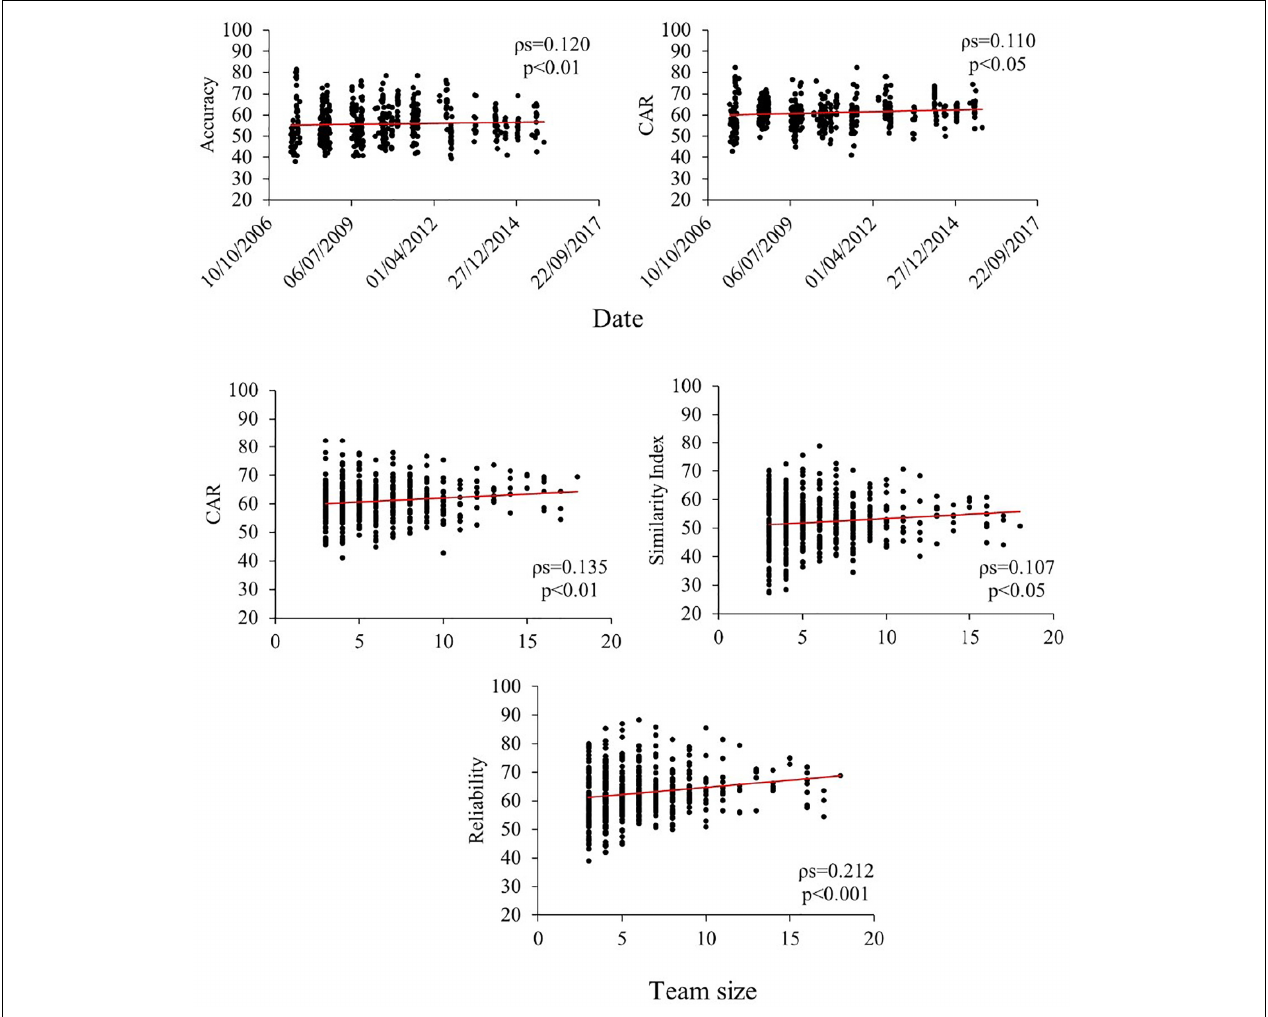
FIGURE 3 | Significant correlations between reliability parameters (Accuracy, CAR, Reliability, and Similarity Index) and independent variables (Date and Team Size). Results based on the 513 validation trials. Indicated in red the trendline of the correlations. ρ s = Spearman correlation coefficient.